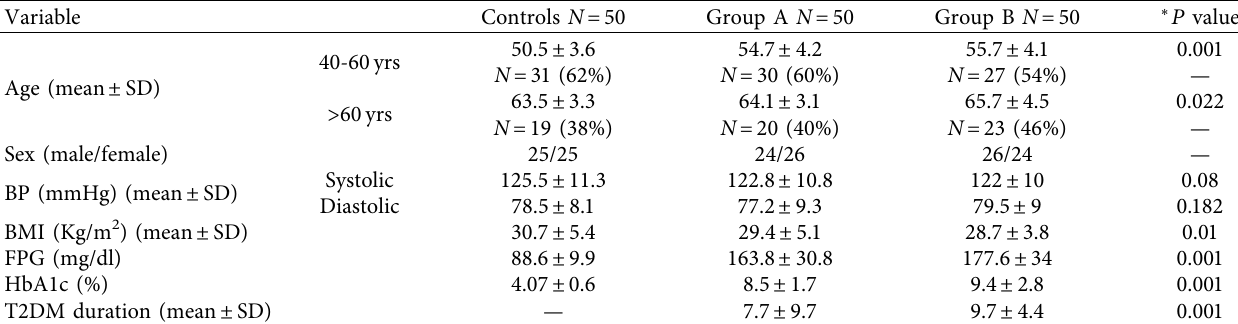
Table 1: Baseline characteristics of the